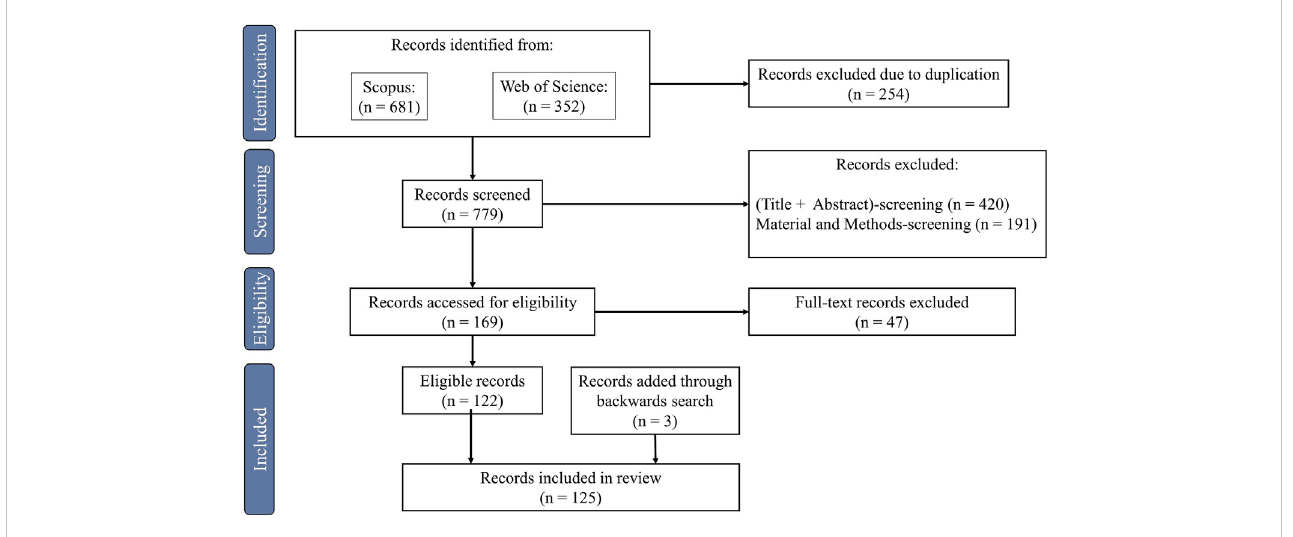
FIGURE 2 PRISMA fl ow diagram of study selection and screening